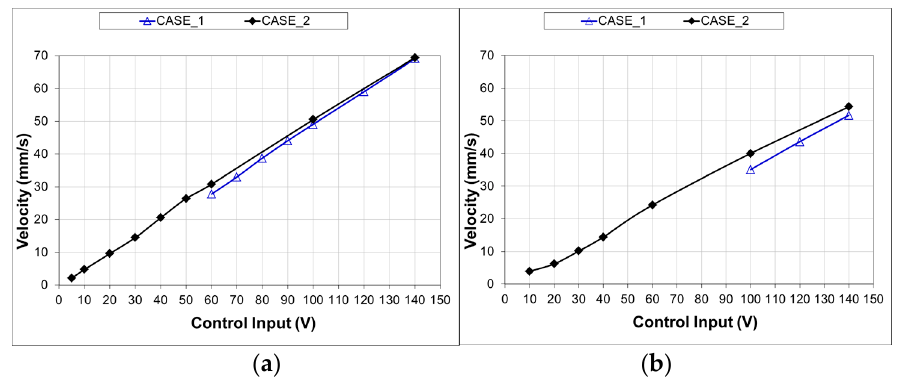
Figure 15. Speed–driving voltage (control input) characteristics for two cases of driving. ( a ) Pre-stress in the normal direction: 35 N, ( b ) Pre-stress in the normal direction: 70 N.